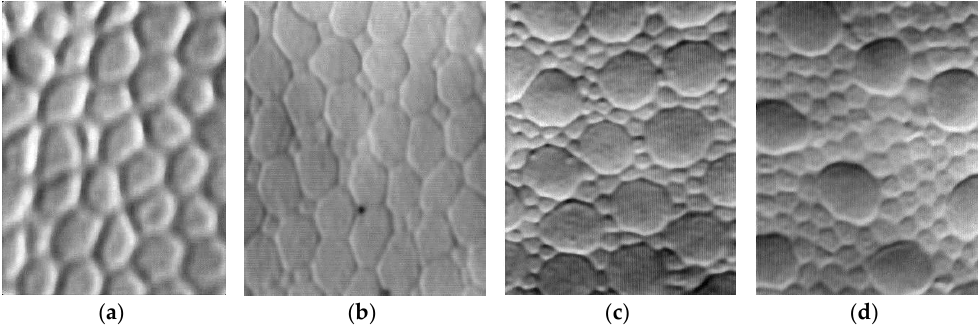
Figure 2. The enhanced and zoomed images of four segments of a human foveal photoreceptor mosaic from the original image printed in [8], From left to right, the segment is chosen from ( a ) the center of fovea, ( b ) the slope of fovea, and ( c , d ) the peripheral areas that are 1.35 mm and 5 mm away from the fovea center respectively.